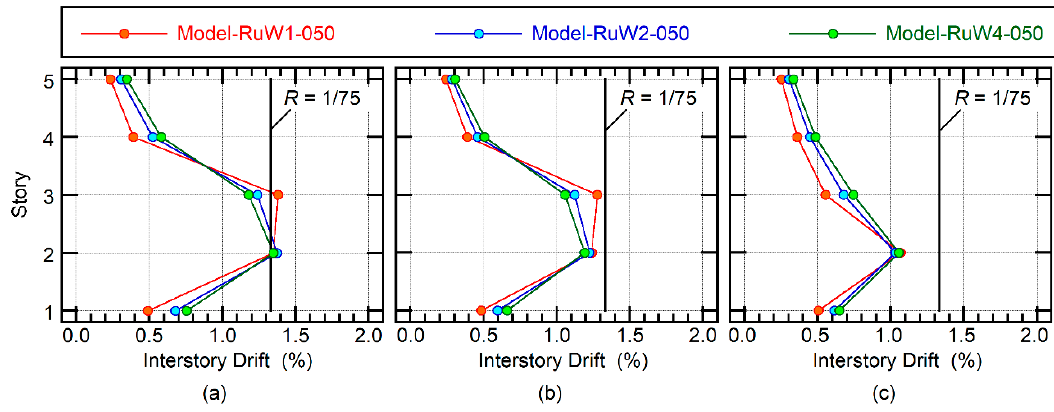
Figure 28. Comparison of the peak drift for columns ( λ = C I, bi ) for Models RuW1-050, RuW2-050, and RuW4-050: ( a ) column A 1 B 1 , ( b ) column A 3 B 1 , and ( c ) column A 3 B 3 .